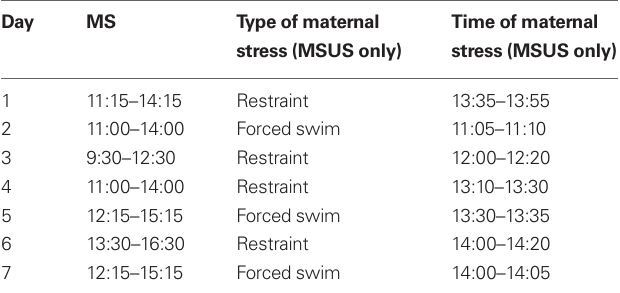
Table 1 | Example of a MSU/MSUS schedule during the first postnatal week.